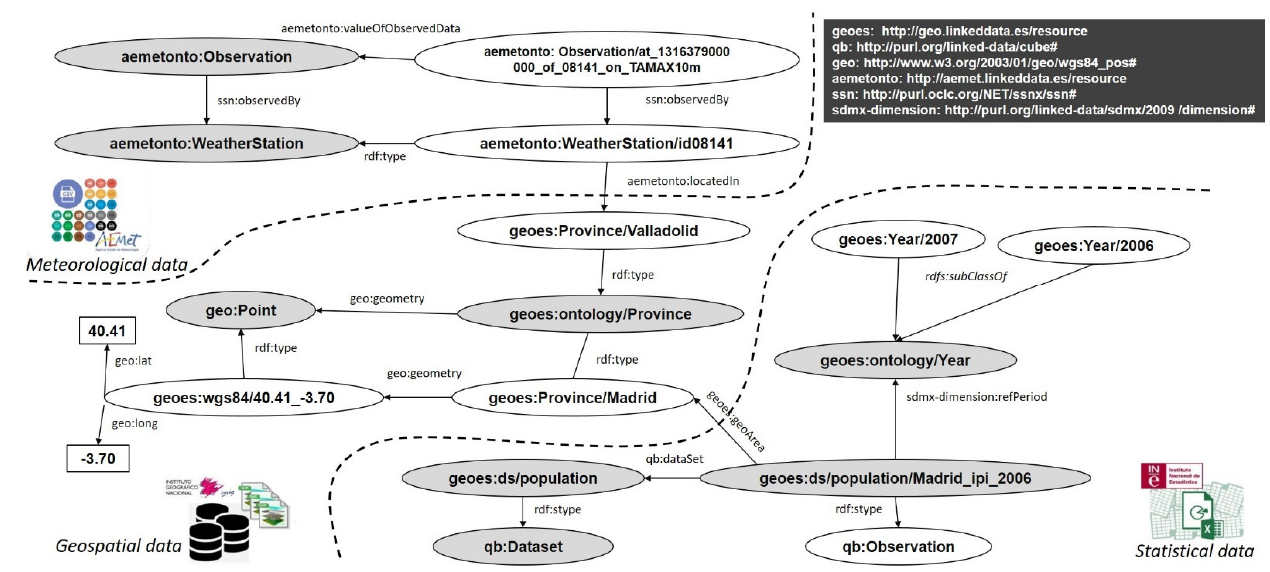
Figure 4. An overview of the Linked Data process. Note the different sections with different type of data (meteorological, geospatial and statistical) and the relationship between all of them.